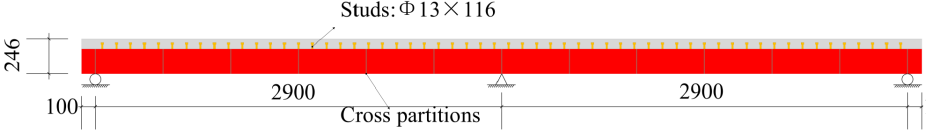
Figure 1. Longitudinal section of specimen.